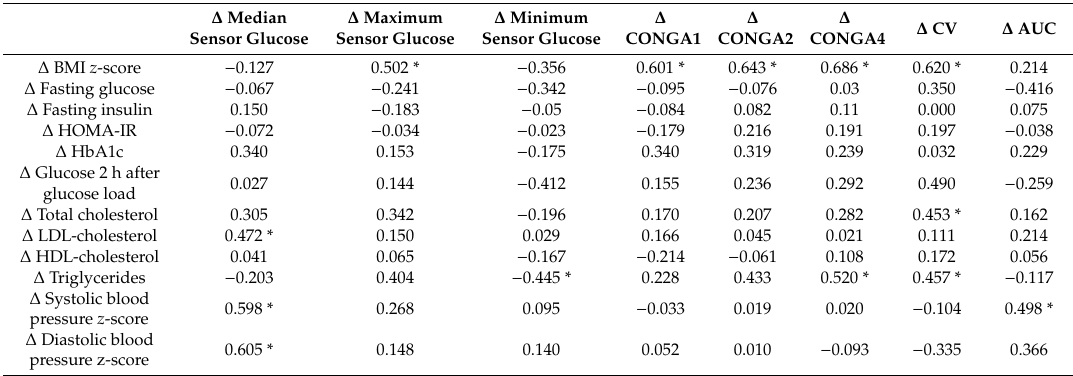
Table 4. Correlation coe ffi cients between baseline characteristics and sensor glucose measurements— subgroup analysis for the children with a decrease in BMI z